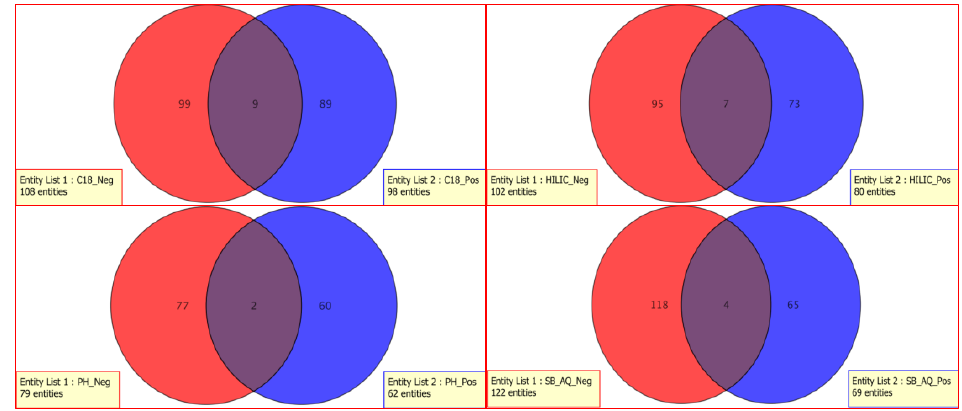
Figure 6. METLIN library matched compounds distribution based on ionization modes.